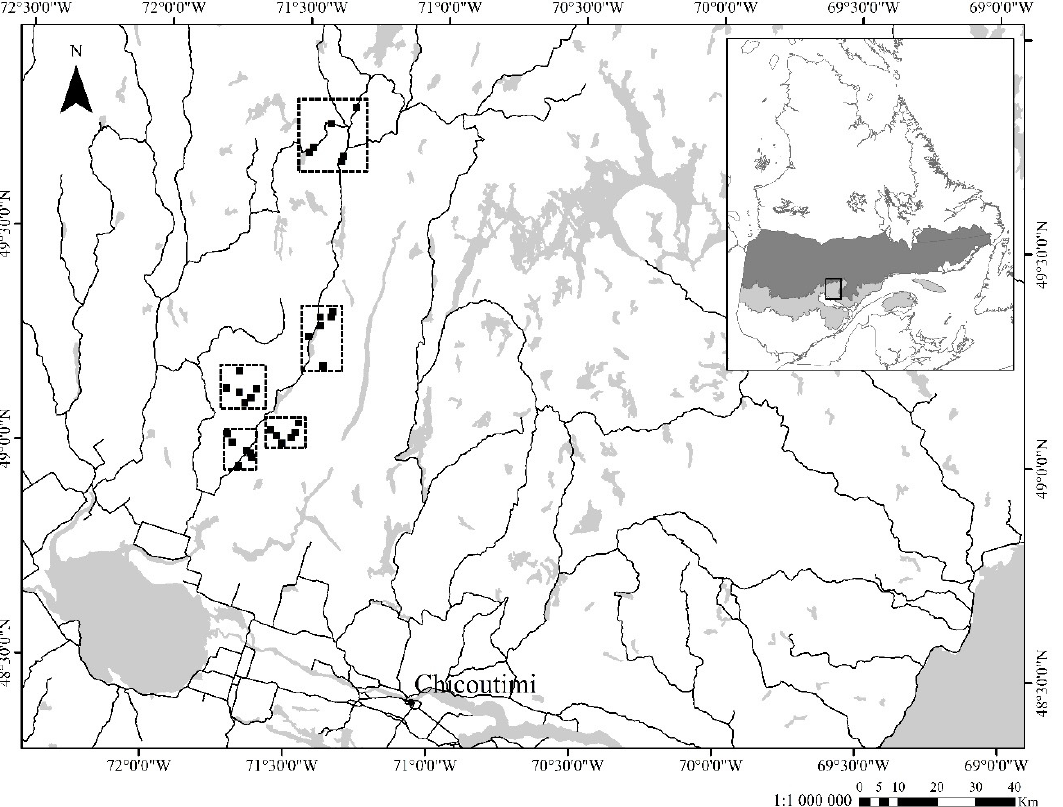
Figure 1. Map of the study area. Black squares represent the experimental sites within the 5 experimental blocks. The inset map shows the balsam fir–white birch (light gray) and the black spruce–feather moss (dark gray) bioclimatic domains.